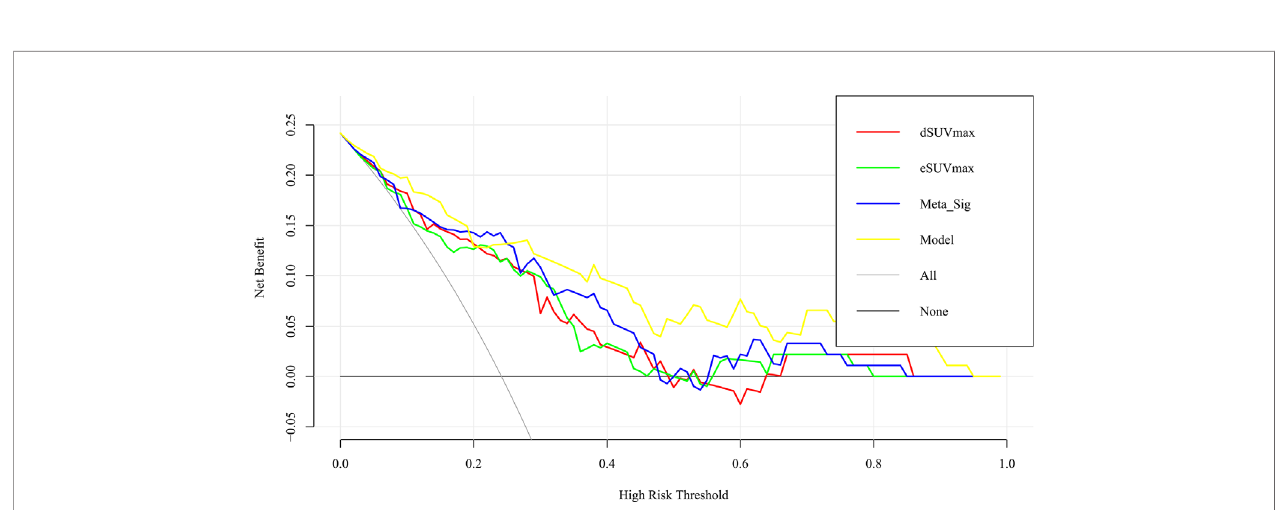
FIGURE 8 | Decision curve analysis for the model and other factors. The y axis measures the net bene fi t. The x axis shows the threshold probability. The yellow line represents the combined model. The blue line represents the Meta-Sig only. The thin gray line represents the assumption that all patients were with TMIT I tumors. The black line represents the assumption that no patients have a TMIT I